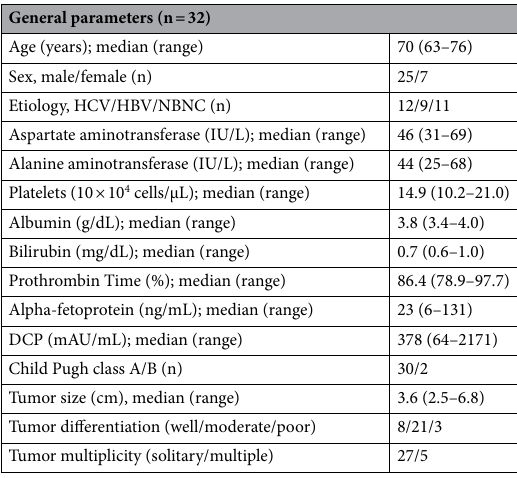
Table 1. Baseline characteristics of 32 patients with HCC.